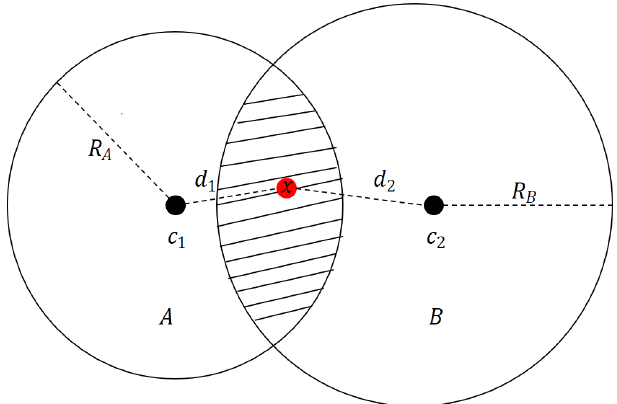
Figure 3. Illustration of POU implicit surface. Two cells, A and B , are associated with their support radius R A and R B , respectively. The value of a point x in the slashed region can be evaluated by ( x ) = b ( 3 d 2 ) ; W ) , where d I M k ( x ) = W A ( x ) Q A + W B ( x ) Q B ; W A ( x ) = b ( 3 d 1 B 1 and d 2 are the distances 2 R A 2 R B W A ( x )+ W B ( x ) from the point x to the c 1 and c 2 , respectively, R A and R B are the support radius, Q A and Q B are local plane